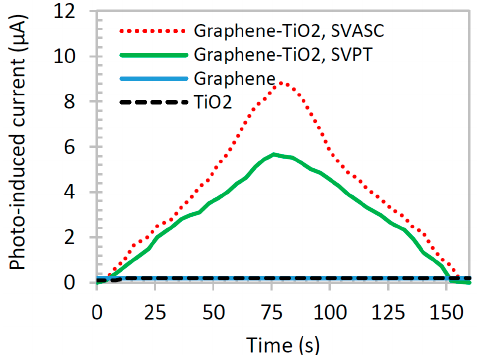
Figure 8. Time-resolved photocurrent generation of TiO 2 , graphene, and graphene-TiO 2 thin films under on and off broadband illumination and 3 V bias. The graphene-TiO 2 thin films were deposited from precursor solution with TS:GD volume ratio of 1:4 and annealed at 150 °C. The illumination was blocked after about 80 s.